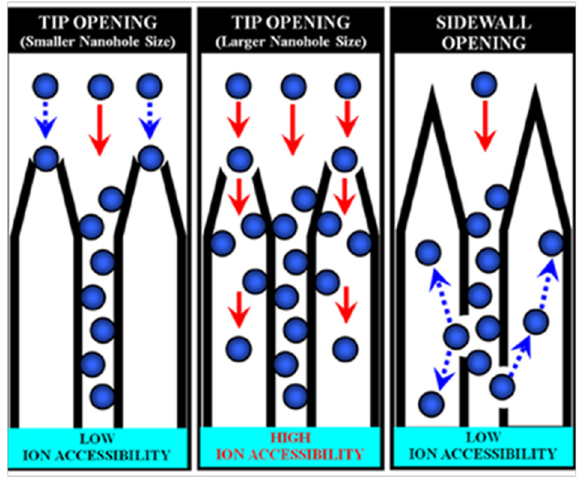
Figure 8. Schematic illustration of ion accessibility with regard to the internal spaces of SWCNHs. Reproduced with permission of [75]; American Chemical Society,